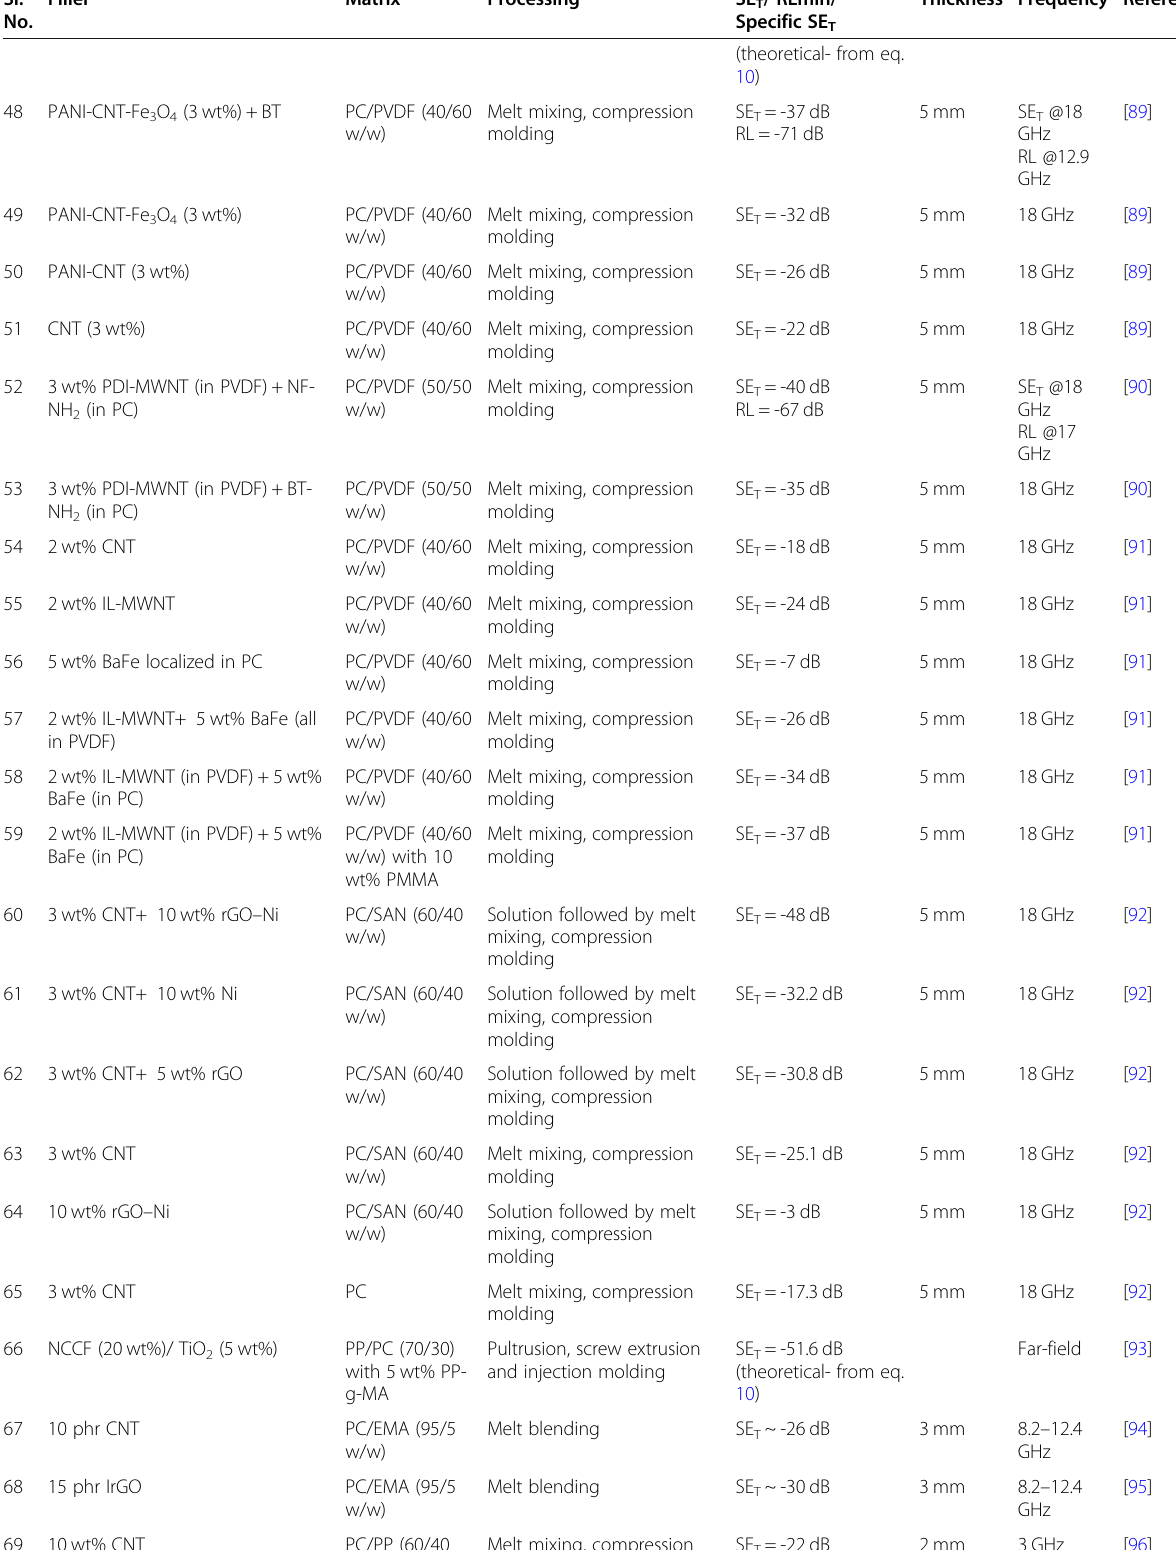
Table 4 List of PC-based hybrid structure for EMI shielding applications (Continued) Sl. No.